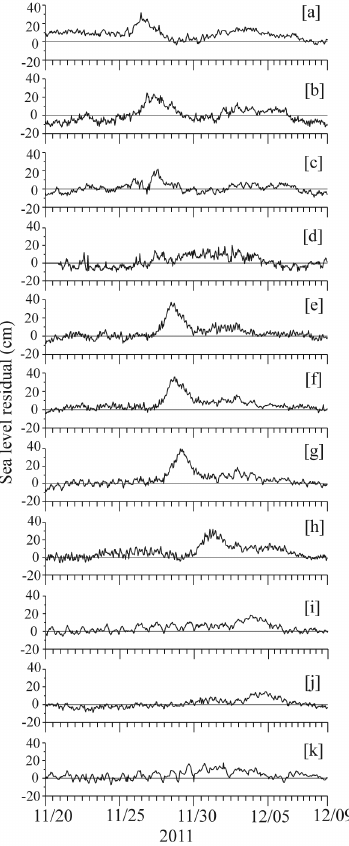
Figure 12. Hourly sea level residual at (a) Colombo, (b) Manda- pam, (c) Tuticorin, (d) Kochi, (e) Karwar, (f) Verem, (g) Ratna- giri, (h) Karachi, (i) Chabahar, (j) Jask and (k) Masirah. Note: 1 – Sea level residual data at Mandapam, Tuticorin, Karwar, Verem and Ratnagiri is hourly averaged. 2 – Sea level data at Colombo, Kochi, Karachi, Chabahar, Jask and Masirah is at hourly interval and downloaded from www.gloss-sealevel.org.